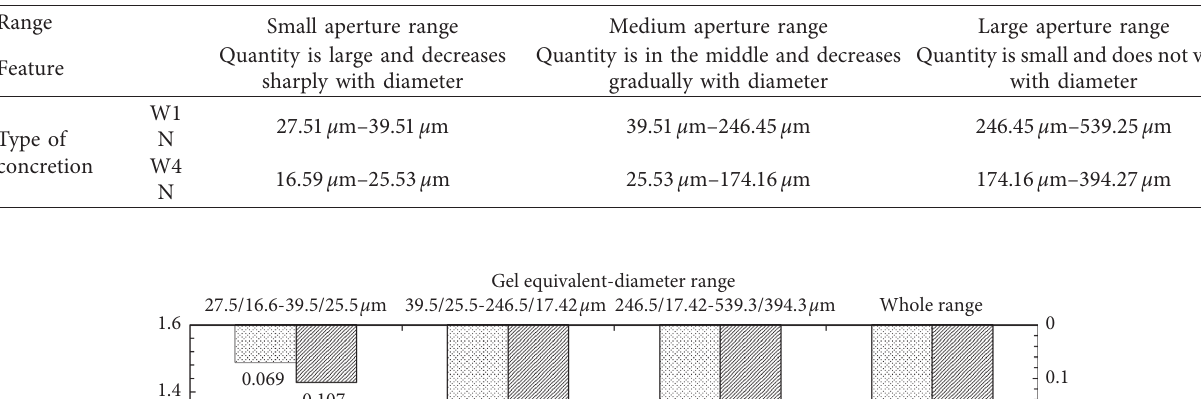
Table 5: Interval of equivalent-diameter range of gel-phase by 3D-XRM.